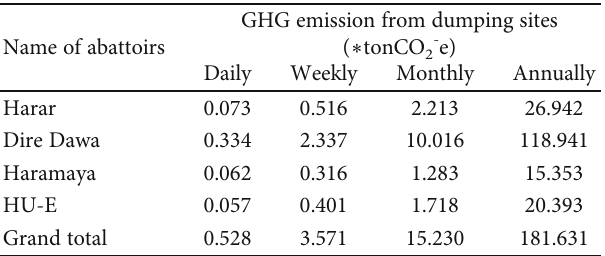
Figure 1: Percentage of waste composition rate of each abattoir from Dec. 1, 2018 to Jan. 2019. Table 2: Annual estimation greenhouse gas emission from disposal sites of abattoirs,